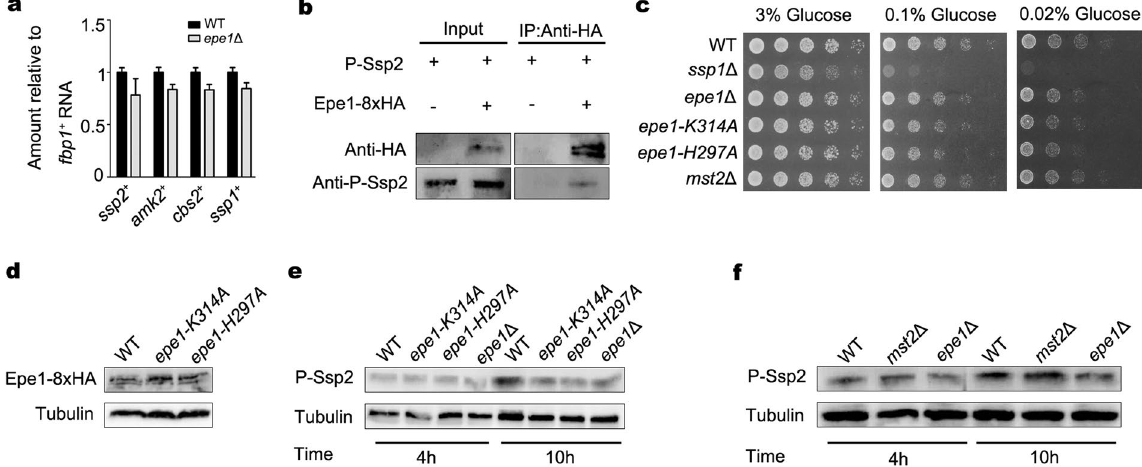
Figure 3. Epe1 is associated with Ssp2 in vivo and novel role of Epe1 requires predicted iron- and 2-oxyglutarate-binding residues inside jmjC domain. ( a ) RT-PCR analysis of mRNA levels of ssp2 + , amk2 + , cbs2 + and ssp1 + relative to a control fbp1 + . The relative level in WT cells was arbitrarily designated as 1. Each column represents the mean ± s.d. from three biological repeats. ( b ) Co-immunoprecipitation assay to analyze the association between Epe1 and Ssp2. Epe1-8xHA immunoprecipitation was followed by the Western blot of phosphorylated Ssp2 (P-Ssp2). Cropped blots are shown for clarity. Full-size blots are shown in Supplementary Figure S6. ( c ) Growth of WT, ssp1 Δ , epe1 Δ , epe1 - K314A , epe1 - H297A and mst2 Δ cells on low-glucose medium in serial dilution assays. ( d ) Western blot to examine the protein levels of Epe1, Epe1-K314A and Epe1-H297A. Full-size blots are shown in Supplementary Figure S7. ( e ) Western blot to examine amount of P-Ssp2 in WT, epe1 Δ , epe1 - K314A and epe1 - H297A cells after growing in YES for 4 or 10 h. Tubulin was detected as a loading control. Full-size blots are shown in Supplementary Figure S8. ( f ) Western blot to examine amount of P-Ssp2 in WT, mst2 Δ and epe1 Δ cells after growing in YES for 4 or 10 h. Full-size blots are shown in Supplementary Figure S9.